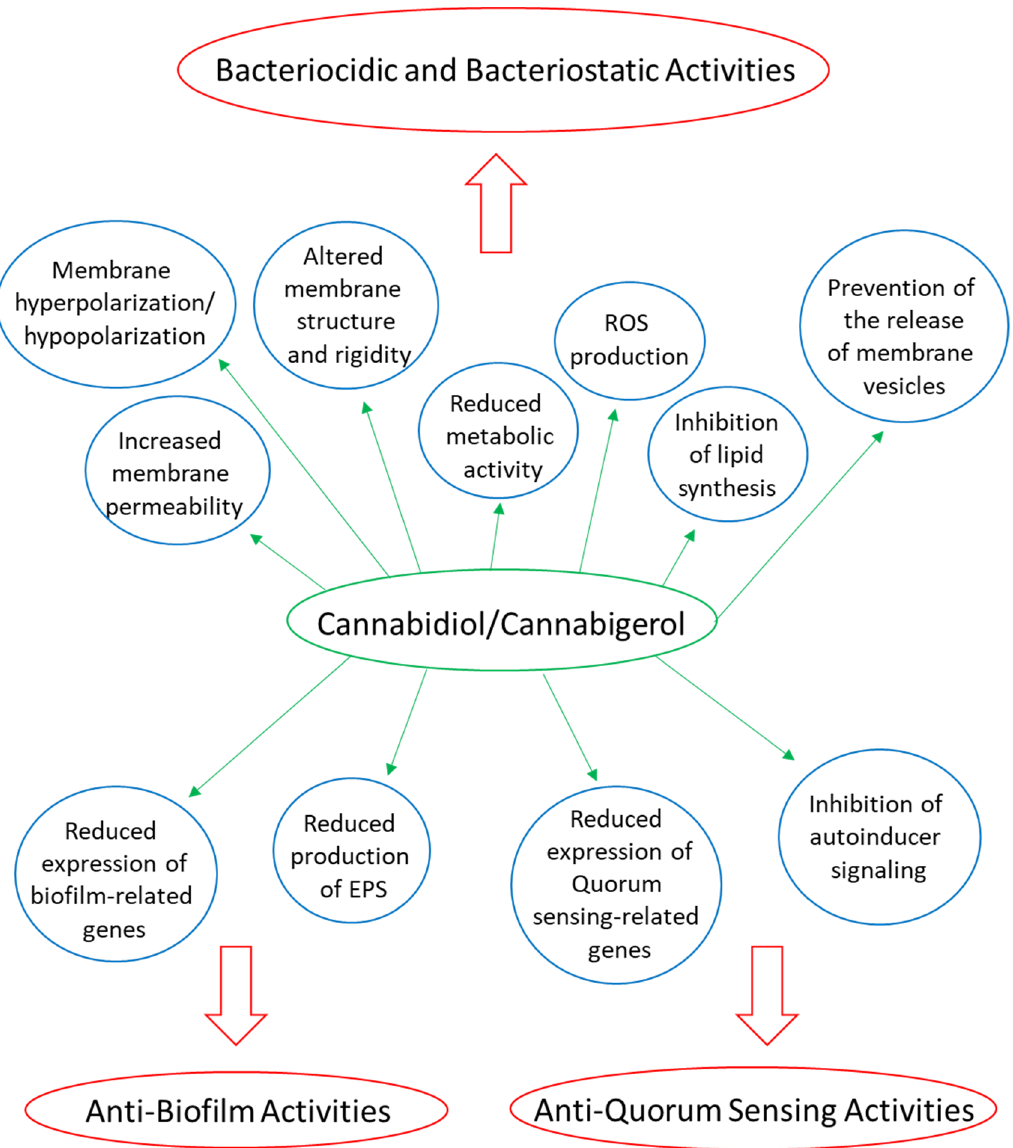
Figure 2. The anti-bacterial activities of phytocannabinoids.